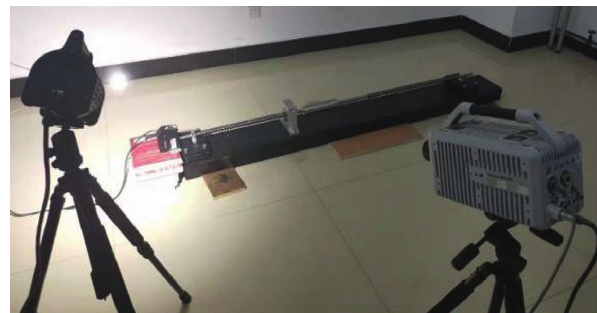
Figure 15: Impact characteristics experiment device for recoil spring.